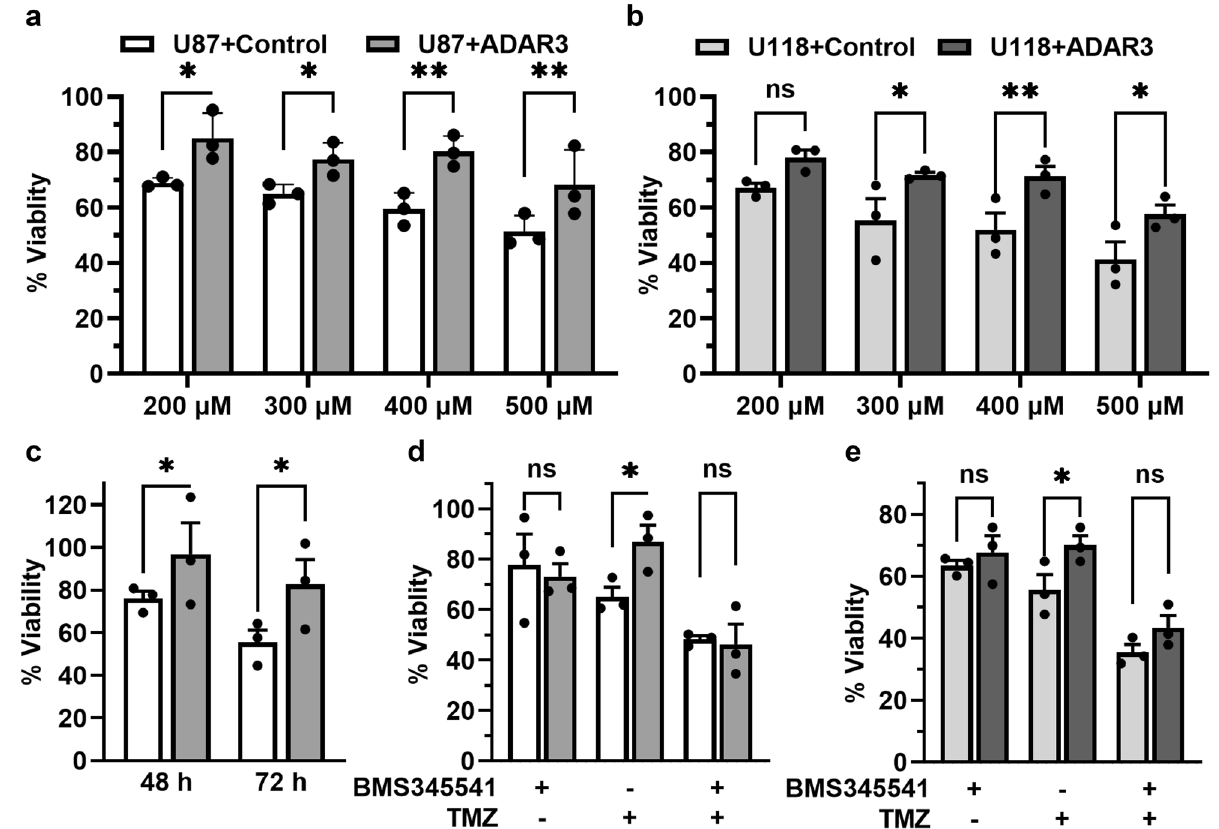
Figure 5. ADAR3 expression increases glioblastoma cell survival to temozolomide and irradiation. ( a , b ) Cell viability of ADAR3-expressing U87 ( a ) and U118 ( b ) cells compared to the respective control cells was determined using an MTT assay. Cells were treated with DMSO or the indicated concentration of temozolomide (dissolved in DMSO) for 48 h. Absorbance was measured at 600 nm after incubation with MTT reagent. The absorbance obtained at 0 h for each sample was subtracted from the 48 h readings and live cells in the TMZ treated cells are represented as the percentage of corresponding DMSO treated cells at each time point. (% Cell viability = [A 600 (t) − A 600 (0)] treatment /[A 600 (t) − A 600 (0)] control ). The mean of three biological replicates is plotted with error bars representing SEM. Statistical significance was determined using two-way ANOVA Fisher’s LSD test. *p ≤ 0.05, **p ≤ 0.005. ( c ) Cell viability of ADAR3-expressing U87 and control U87 cells was determined 48 and 72 h after 5 Grays of gamma irradiation using the MTT assay and formula described above. Statistical significance was determined using two-way ANOVA Fisher’s LSD test. *p ≤ 0.05 ( d , e ) Cell viability of control and ADAR-expressing U87 ( d ) and U118 ( e ) cells at each treatment condition was determined using MTT assay as mentioned above. Cells were incubated with DMSO, 400 μM of temozolomide, 5 µM BMS345541 or both temozolomide and BMS345541 for 24 h. The mean of three biological replicates is plotted with error bars representing SEM. Statistical significance was determined using two-way ANOVA Fisher’s LSD test. *p ≤